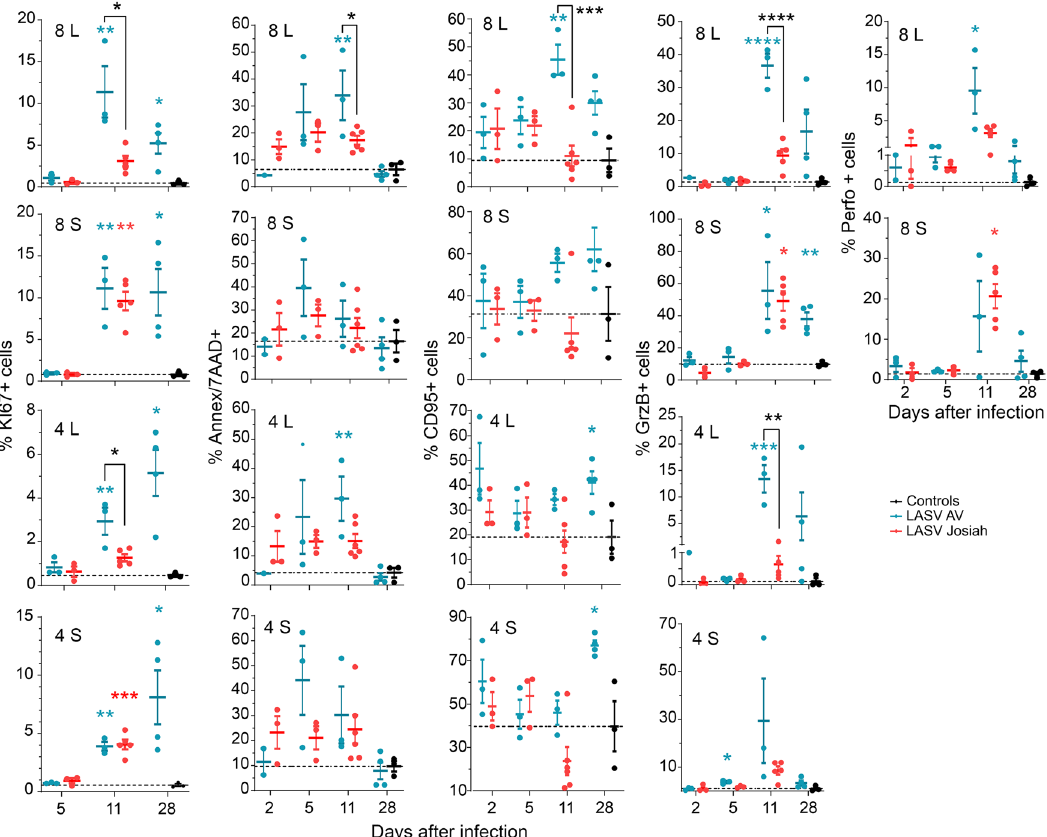
Fig. 7 Analysis of T-cell responses in SLO. The percentage of CD8 + and CD4 + T cells in MLNs (L) and spleen (S) expressing KI67, Annexin V and 7AAD (Ann/7AAD), CD95, GrzB, or perforin (Perfo) is presented in control (black dots), AV-infected (blue dots), and Josiah-infected (red dots) animals. Results show the individual data and the mean ± SEM for each group ( n = 3). * p < 0.05, ** p < 0.01, *** p < 0.001, *** p < 0.0001, as determined by a one-way ANOVA or a Kruskal – Wallis multiple comparisons test. Signi fi cant differences are presented as in Fig.